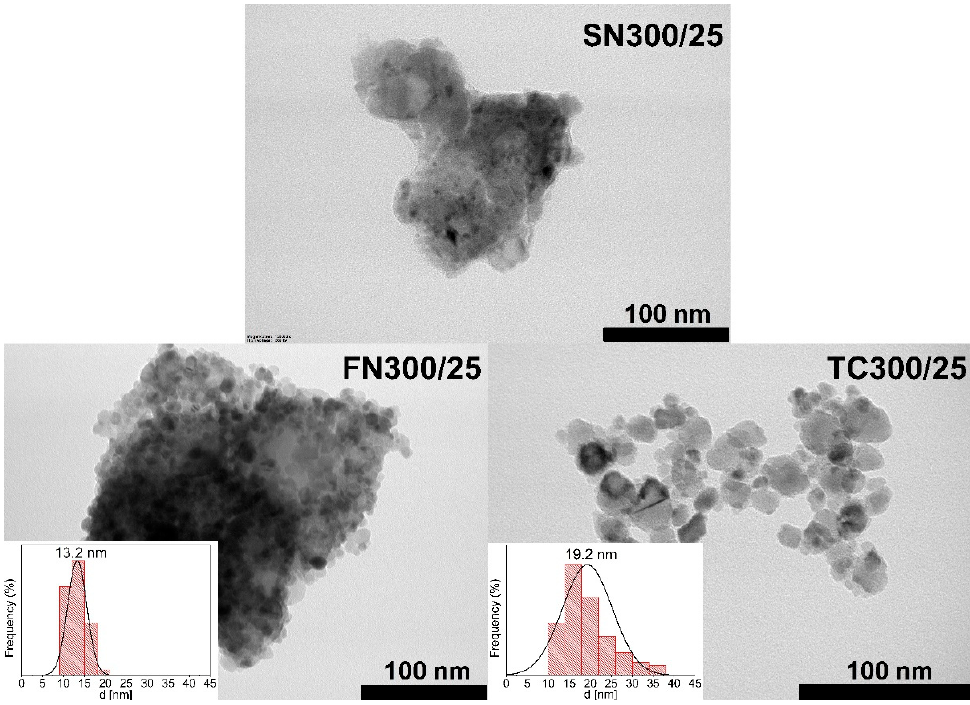
Figure 6. TEM images of BaTiO 3 perovskites synthesized in the Si3N4 (SN300/25), FeNi (FN300/25) and TC (TC300/25) grinding vessels.